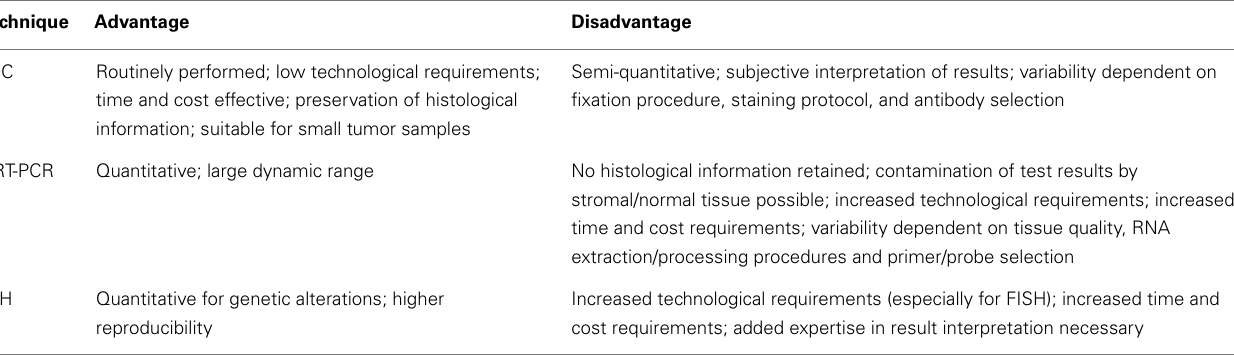
Table 1 |Advantages and disadvantages of currently used companion diagnostic